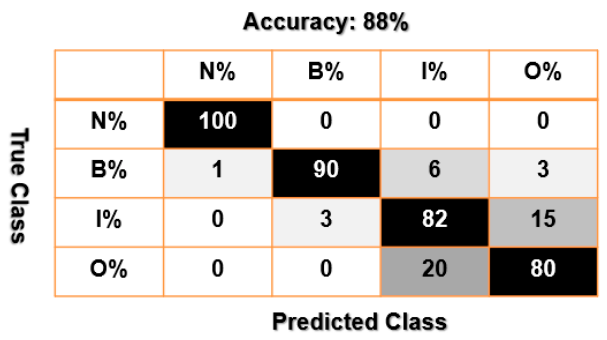
Figure 12. Bearing’s data classification using the combination of VS and SVM.